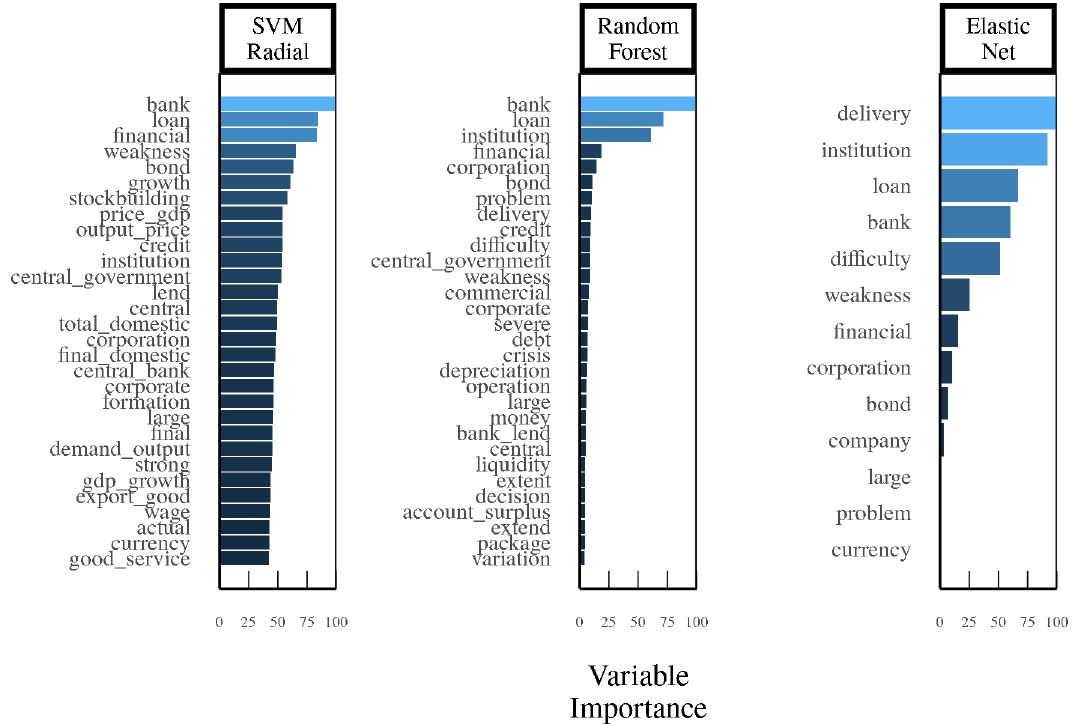
Figure 6. Variable Importance for R&R Minor Crises on OECD Text . Note: This figure shows variable importance for three machine learning models based on Romer and Romer (2017) 5+ severity crises trained on OECD text from 1981–2004. Variable importance is based on the percentage gain of the area under the curve (AUC) when including a particular word in the model. Words such as “bank” and “loan” provide valuable insight for the purpose of detecting crises. The variable importance charts between our main machine learning models (SVM Radial and Random Forest) are